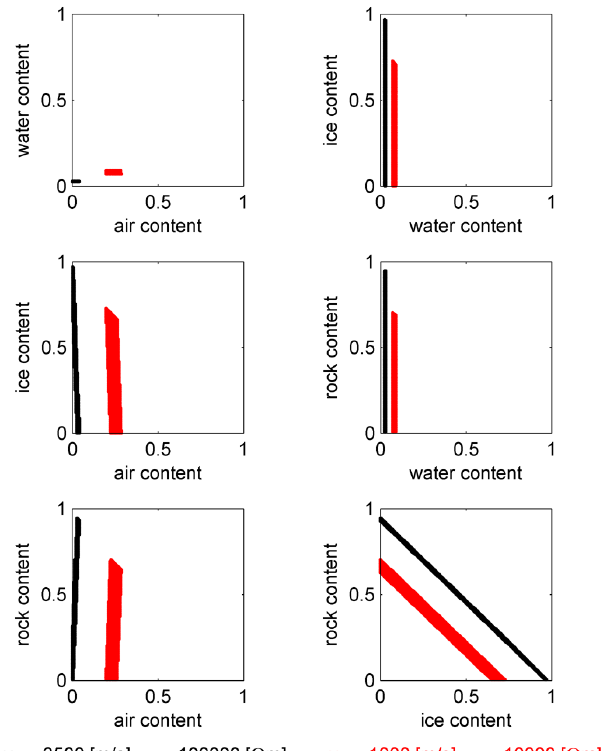
Fig. 3. Relation between the estimates of the four phases for the general model approach without prescribed porosity. All possible solutions are shown for two pairs of P-wave velocity and electrical resistivity. (black) 3500ms − 1 and 100K (cid:127) m representing high ice content conditions and (red) 1000ms − 1 and 10K (cid:127) m representing low ice content